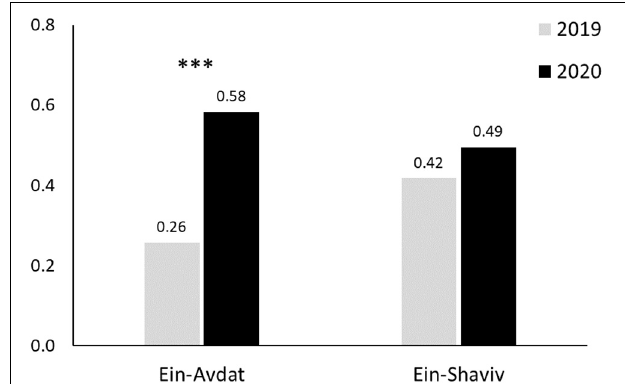
FIGURE 6 | Female:Kids Ratio in Ein Avdat and Ein Shaviv in 2019 and 2020. Three stars represent significance of p <